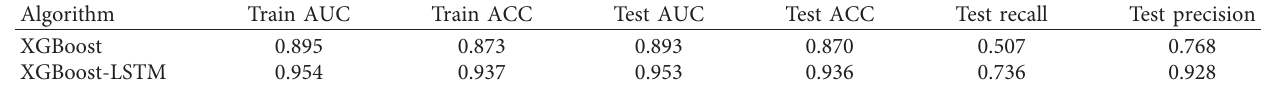
Table 8: Model evaluation indicators for XGBoost model and XGBoost-LSTM model. Algorithm Train AUC Train